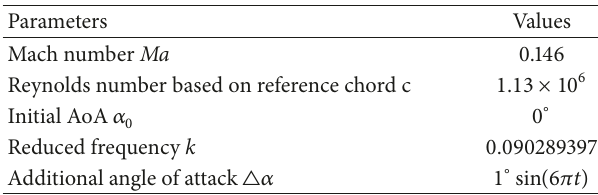
Table 1: Simulation conditions.